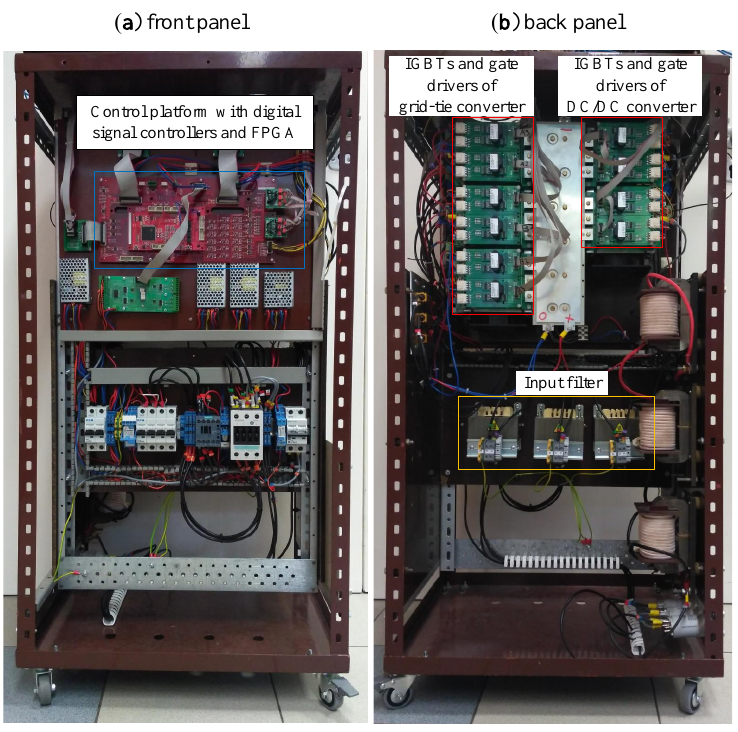
Figure 13. Photo of the power electronic system.